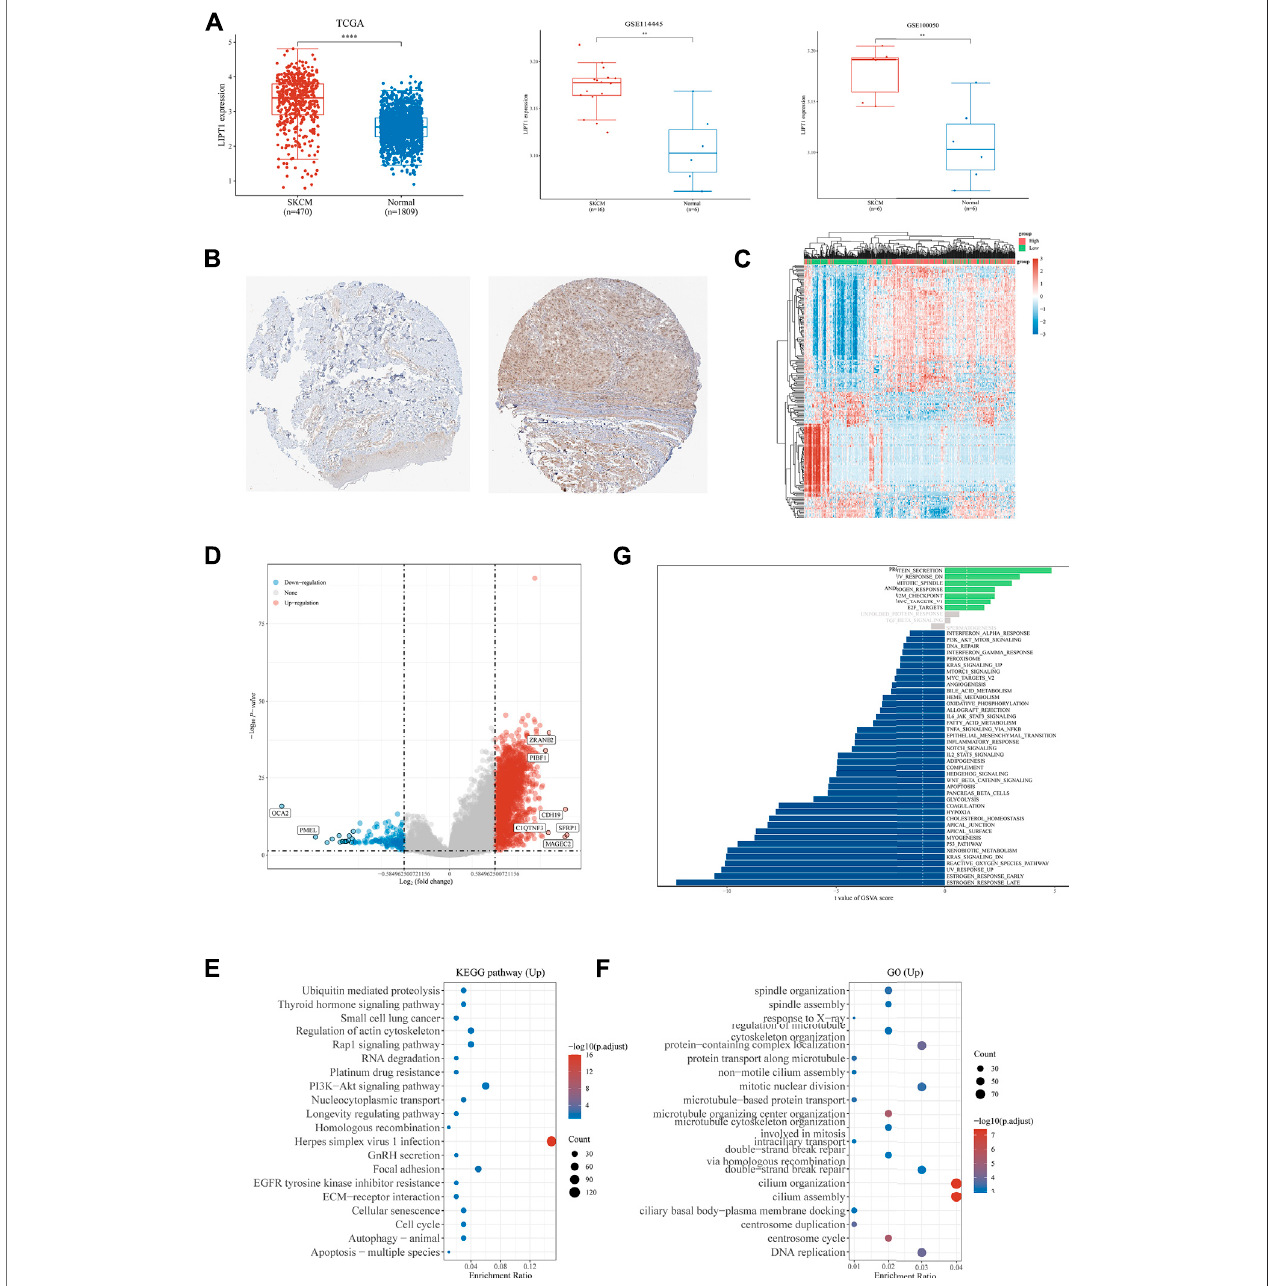
FIGURE 3 | Analysis of the LIPT1 gene expression in SKCM. (A) Compared to normal tissues, LIPT1 was upregulated in SKCM tissues in the TCGA database, GSE114445, and GSE100050. (B) Immunohistochemistry analysis showed that LIPT1 was highly expressed in SKCM tissue (right) compared with normal skin tissue (left) inthehumanprotein atlas(antibodyHPA034802).Theheatmap (C) andVolcano plot (D) ofthedifferentialgeneexpression betweenhighand lowexpressed LIPT1 in SKCM. (E,F) The most signi fi cant KEGG pathways (E) and GO enrichment (F) between high and low expressed LIPT1 in SKCM. (G) Up and downregulation of LIPT1 was associated with activation of multiple pathways by GSVA. ** p < 0.01 and **** p < 0.0001.